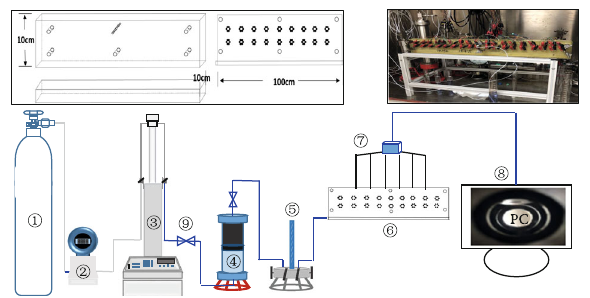
Figure 1: Models and experiment design of physical simulation.